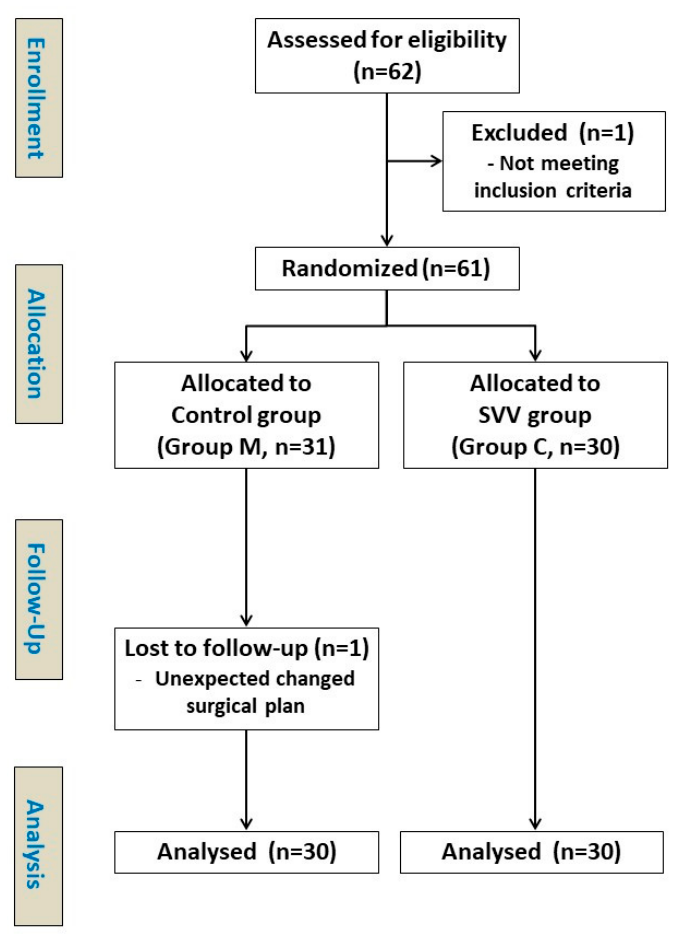
Figure 1. CONSORT diagram.